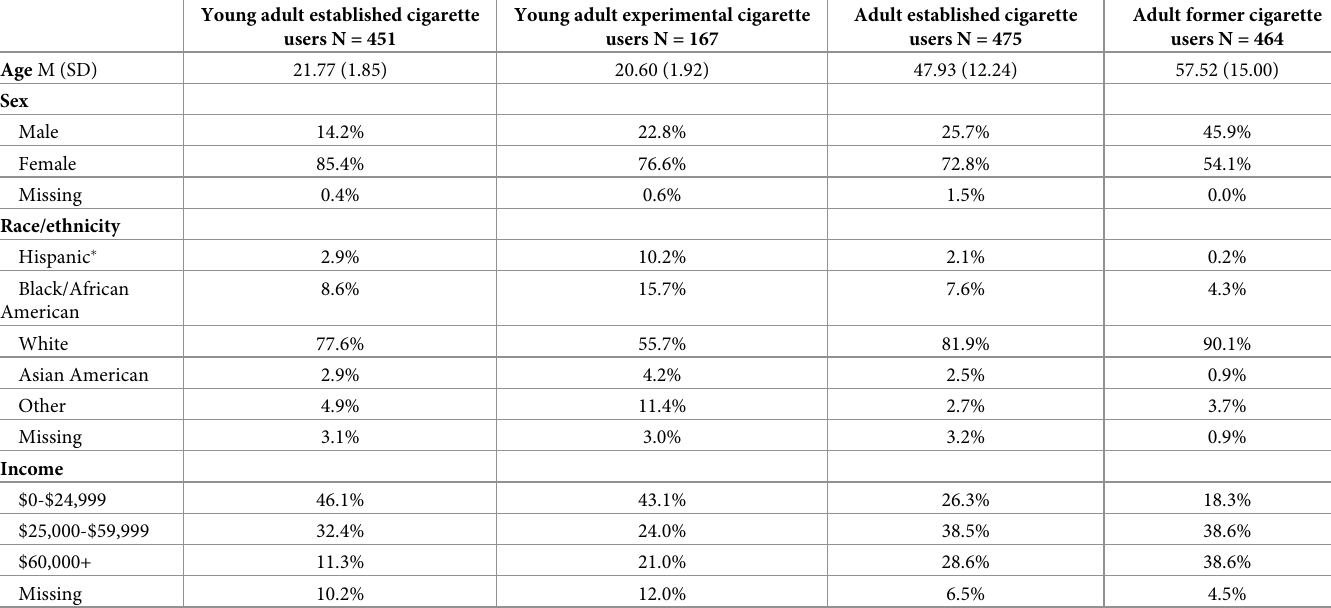
Table 1. Descriptive statistics by sample.